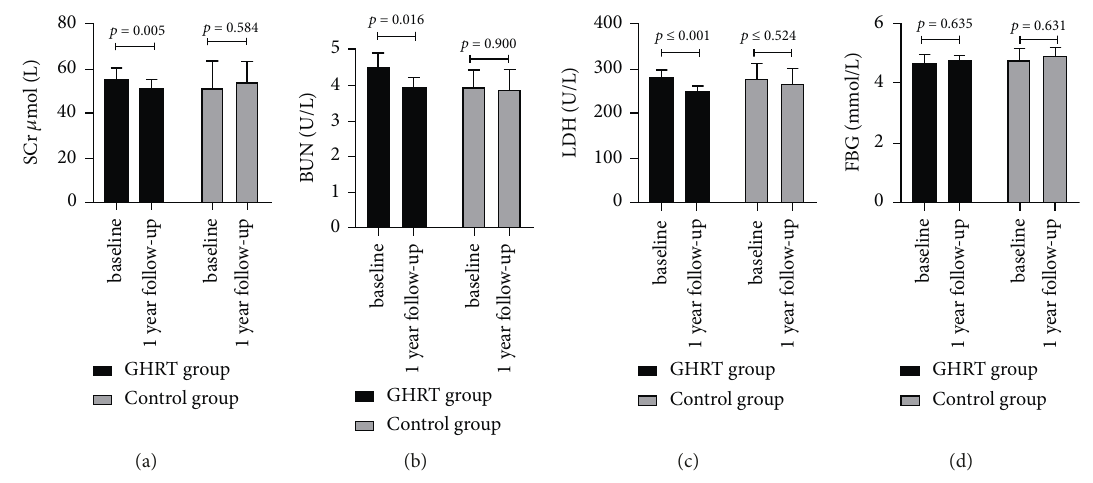
Figure 5: Changes in SCr, BUN, LDH, and FBG levels after one year of treatment. Table 1: Comparison of the GHRT and control group baseline